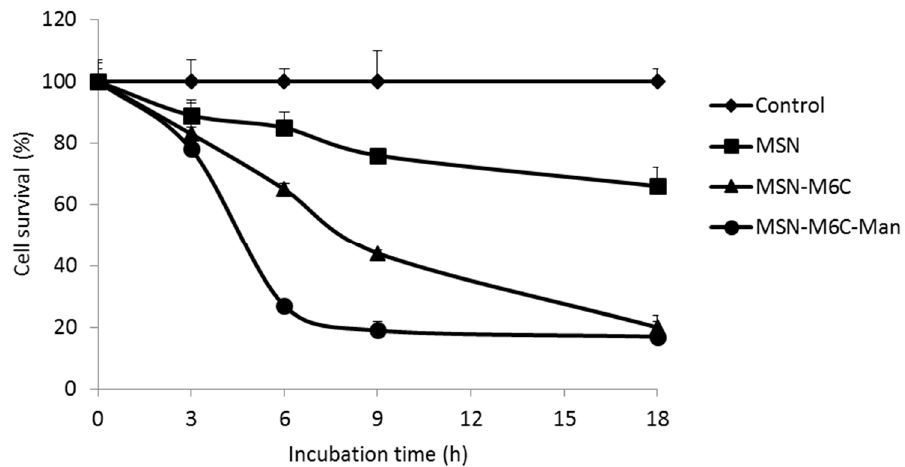
Figure 1. LNCaP cell survival after incubation with MSN, MSN-M6C, or MSN-M6C-Man and irradiation at 650 nm.